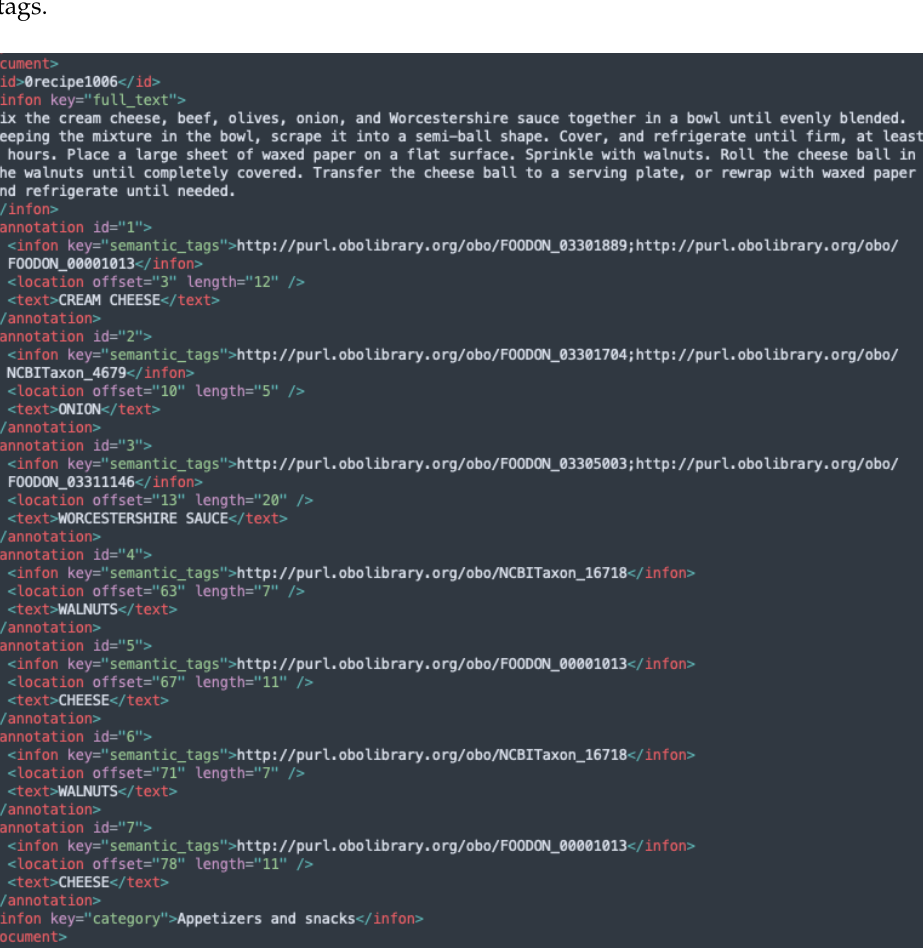
Figure 3. Example of an instance from FoodBase annotated with tags from the FoodOn